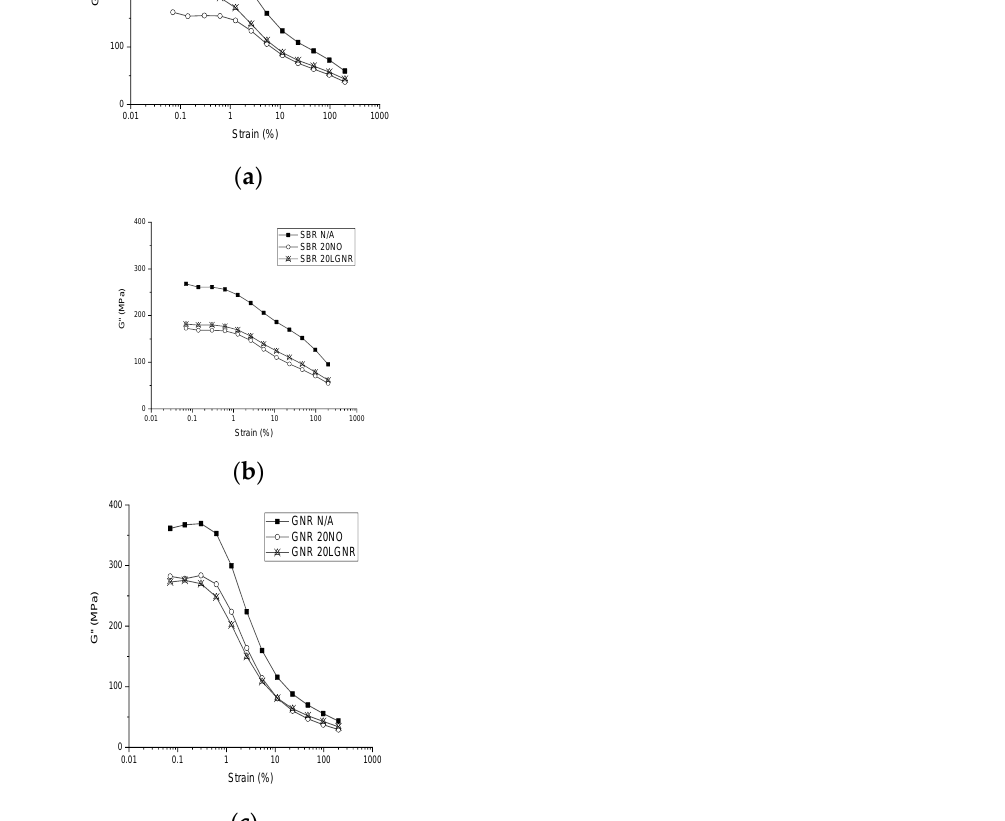
Figure 3. Loss modulus (G”) of rubber compounds with or without processing aids from 0.07% to 200% strain amplitude: ( a ) Hevea natural rubber (HNR); ( b ) styrene butadiene rubber (SBR); ( c ) guayule natural rubber (GNR). N/A: rubber compounds without processing aids; 20 NO: rubber compounds with 20 phr naphthenic oil; 20 LGNR: rubber compounds with 20 phr liquid guayule natural rubber.